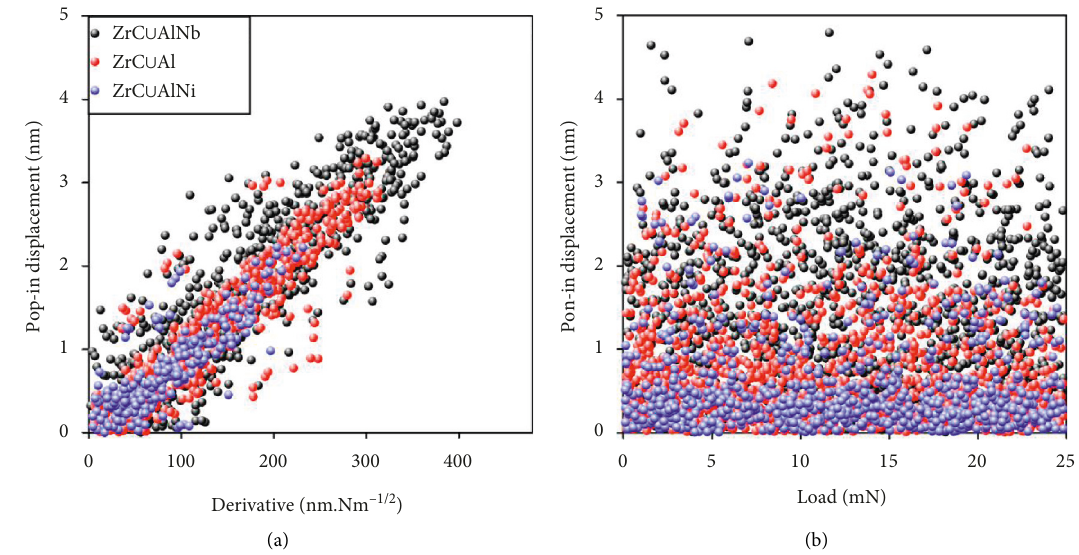
Figure 8: Pop-in displacement variations as a function of (a) load derivative and (b) load